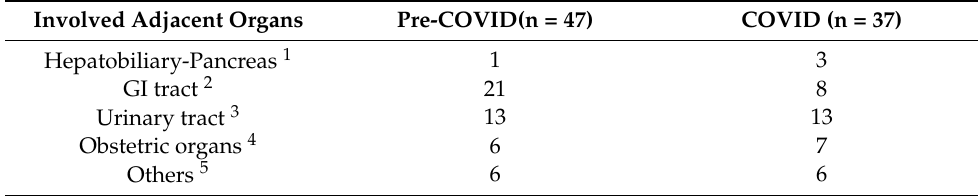
Table 3. Organs involved in patients who underwent resection of adjacent organs.